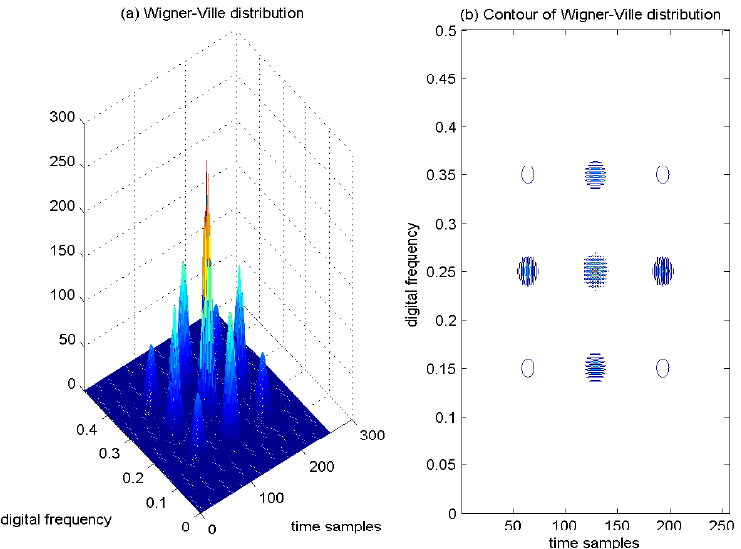
Figure 2. Wigner–Ville distribution of four Gaussian components’